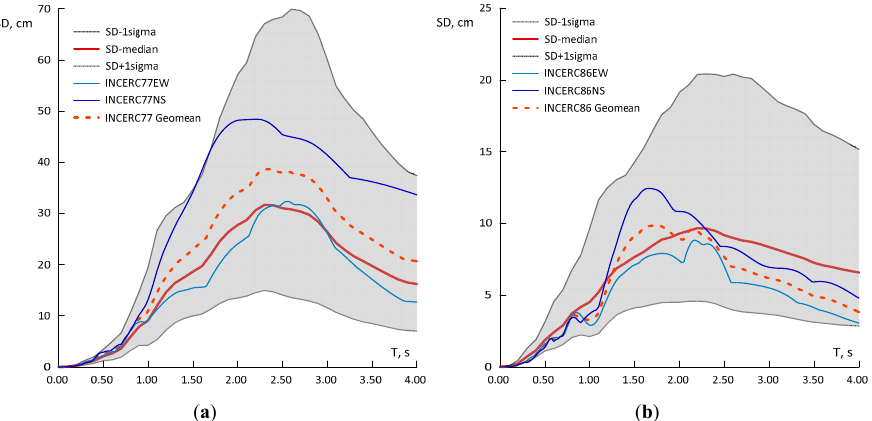
Figure 10. Predicted and computed displacement spectra for two large earthquakes recorded at the INCERC site, with quadratic term ( a ) 4 March 1977; ( b ) 31 August 1986.